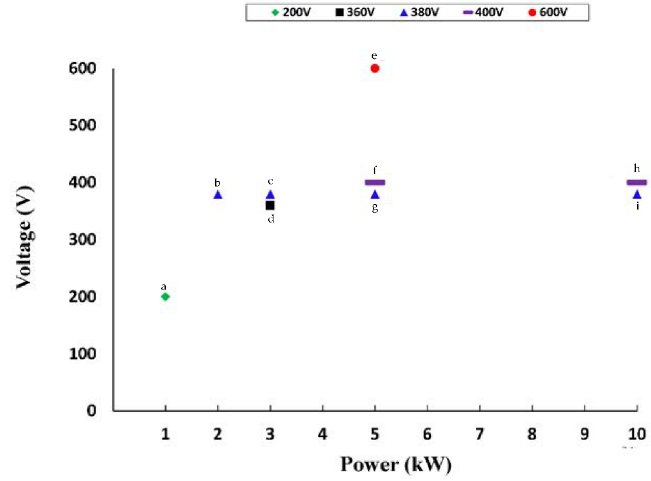
Figure 3. DC-bus voltage level integrated with a bidirectional inverter. a — [39,40]; b — [41]; c — [42]; d — [43]; e — [44]; f — [45 – 50]; g — [51 – 55]; h — [38,56,57]; i — [58].